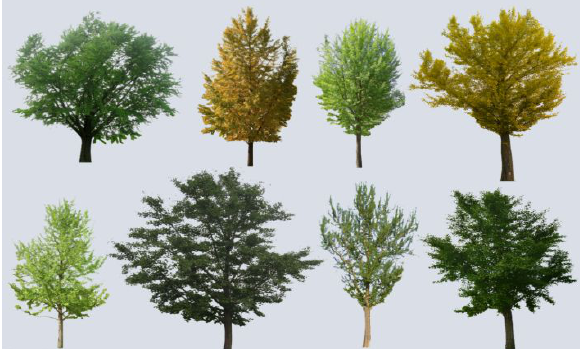
Figure 7. Ginkgo biloba of different postures and different seasonal aspects